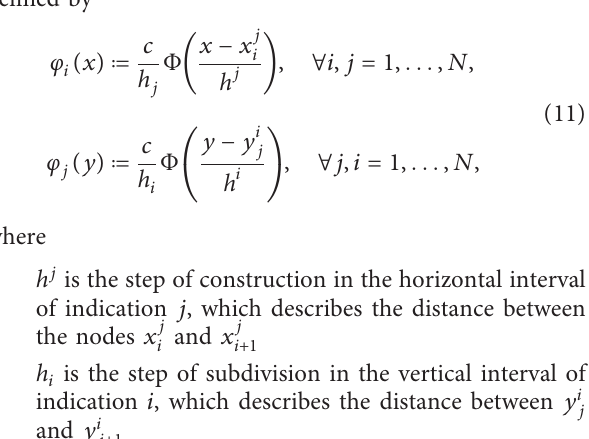
Figure 4: Sweeping the interior of the domain by a set of horizontal and vertical segments and position of the nodes.